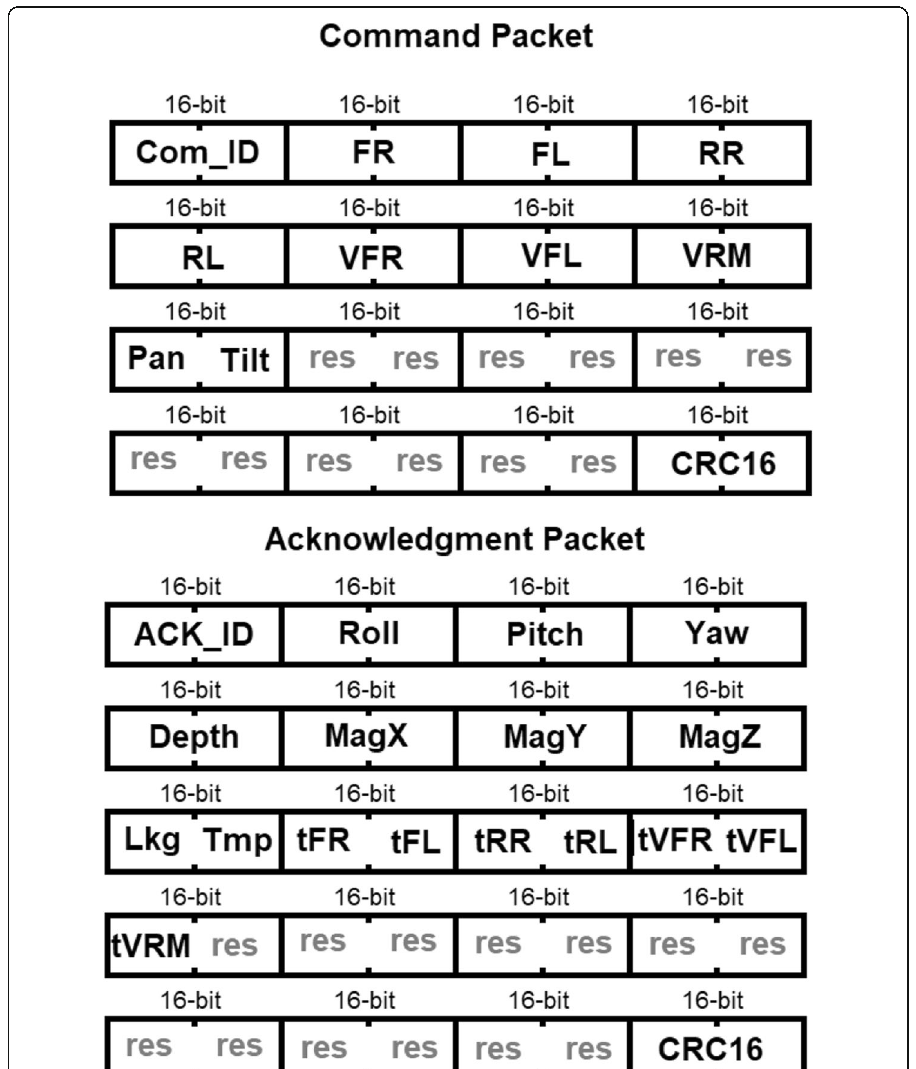
Fig. 5 Communication packets